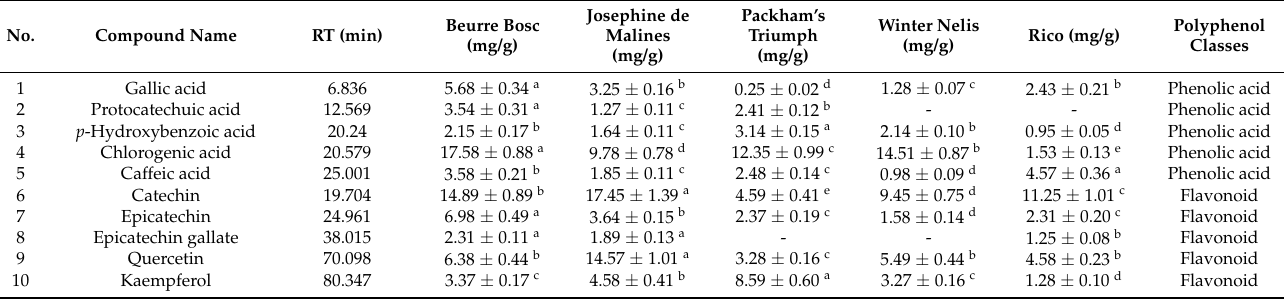
Table 4. Quantification of phenolic compounds in pears by using